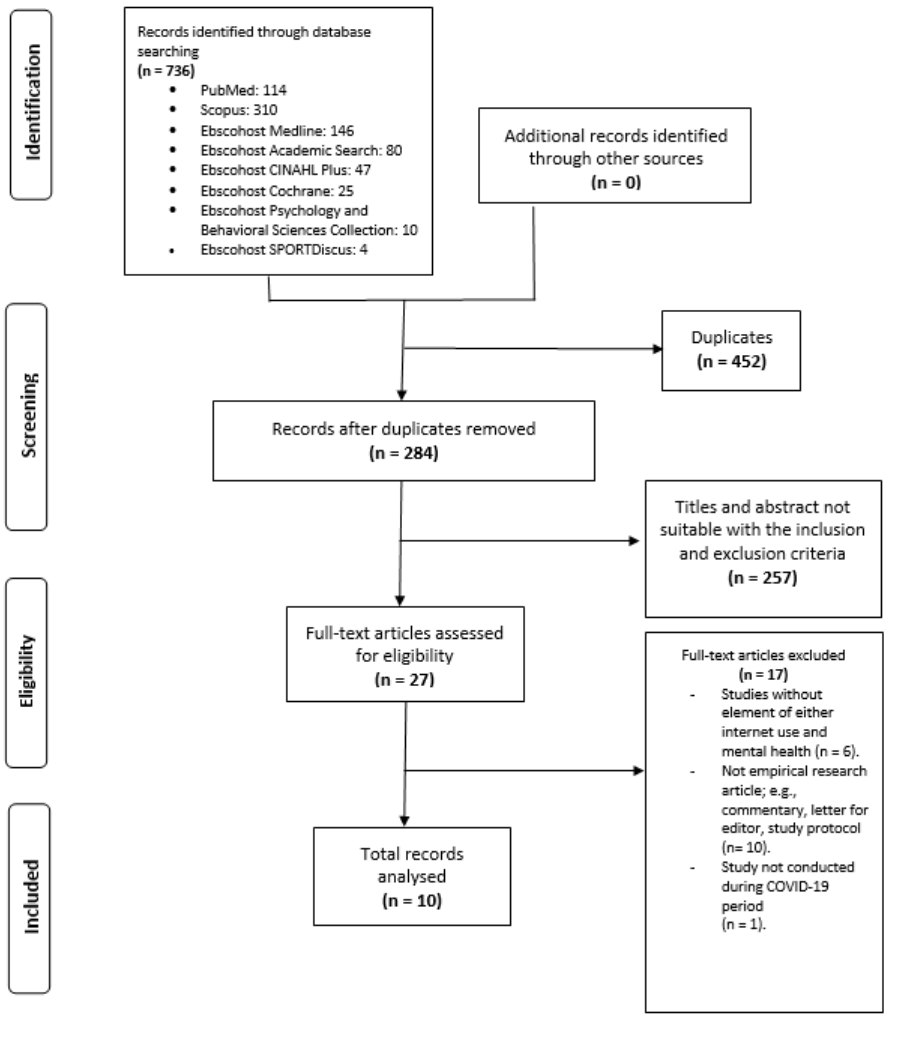
Figure 1. Review Figure 1. Review flowchart.